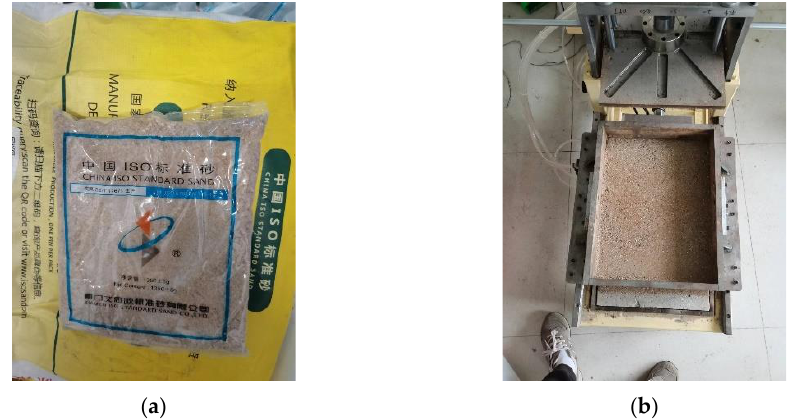
Figure 4. Preparation of the standard sand : ( a ) Standard sand unsealing and ( b ) Standard sand box.